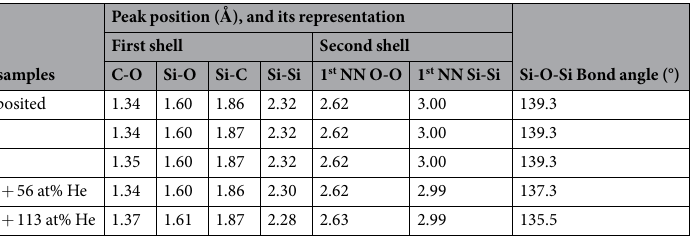
Table 1. Average peak position of neighbor shells and bond angles in SiOC before and after He irradiation/